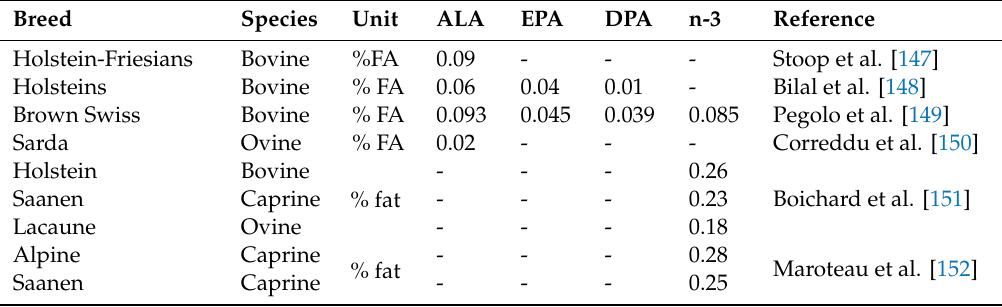
Table 6. Heritability estimates of major individual and group of n-3 fatty acids. Breed Species Unit ALA EPA n-3 Reference